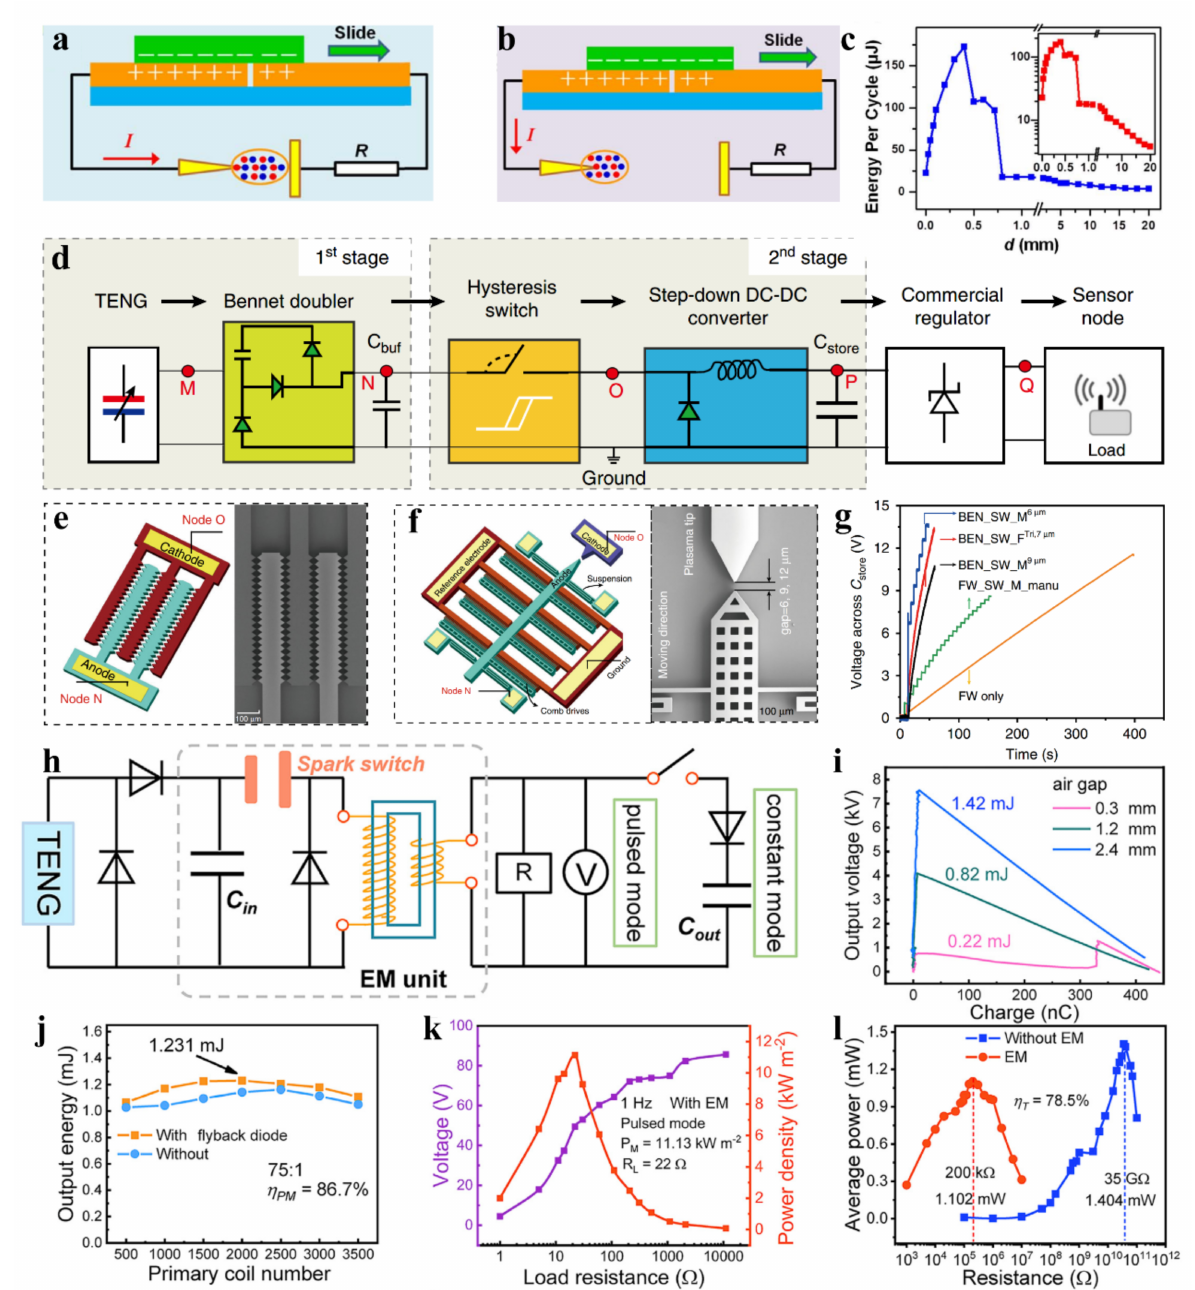
Figure 6. Power management with spark switch. ( a ) Arc discharge. ( b ) Corona discharge. ( c ) The relationship between the discharge energy per cycle and the electrode spacing. Reproduced with permission [72]. Copyright 2018, Elsevier. ( d ) The circuit architecture of the energy harvesting and conditioning. ( e ) Fixed switch. ( f ) Movable switch. ( g ) Comparison of charging rates for different switch configurations. Reproduced with permission [65]. Copyright 2020, Nature . ( h ) The circuit architecture of power management with spark switch. ( i ) Comparison of output energy by C in under different air gaps. ( j ) The dependence of output energy and transformer primary coil number. ( k ) The dependence of the voltage and power density on load resistance in pulse mode. ( l ) Comparison of average power between power management and standard circuit. Reproduced with permission